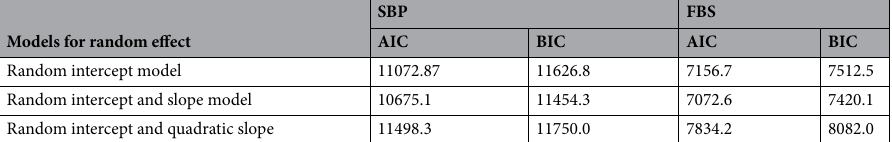
Table 4. Selection of random effects to be included in the linear mixed effect model for FBS and SBP hypertension patients data. AIC Akaike information criteria, BIC Bayesian information criteria, SBP Systolic blood pressure, FBS Fasting blood